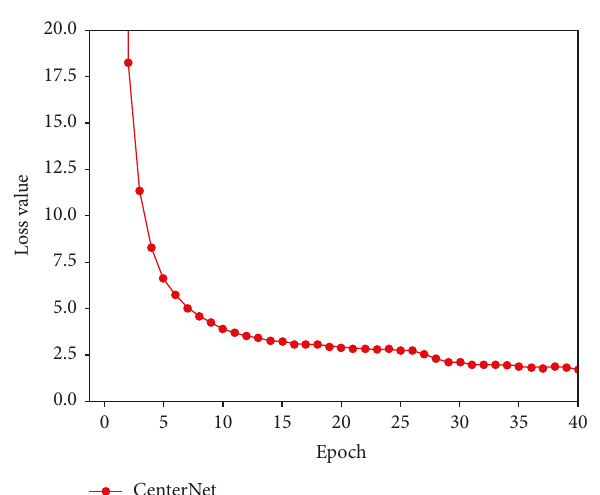
Figure 4: Loss curve trained by CenterNet.